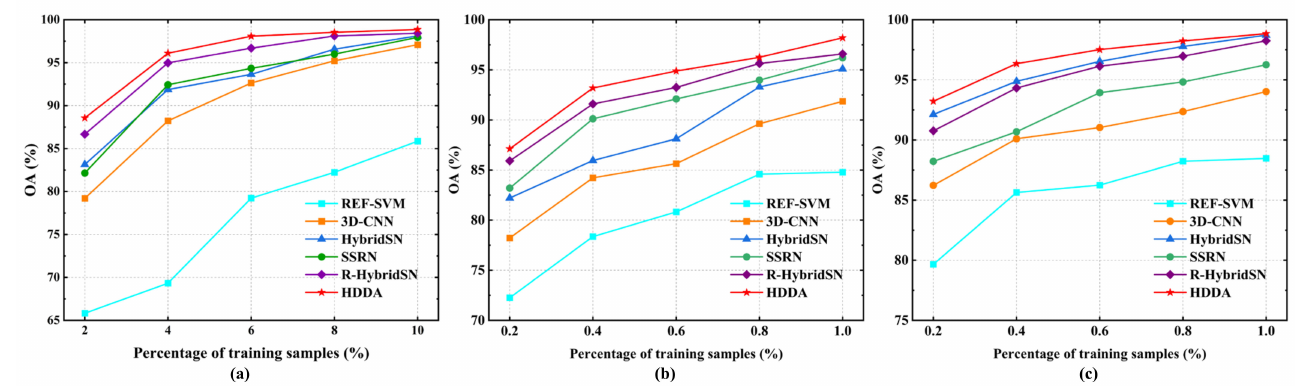
Figure 15. Comparison of OA for six methods using different training percentages: ( a ) IP; ( b ) PU; ( c )